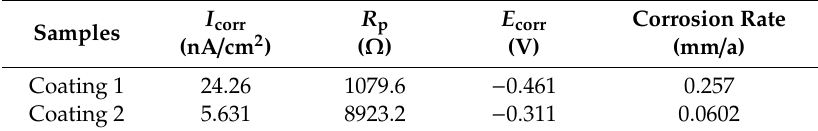
Table 5. Fitting results of polarization